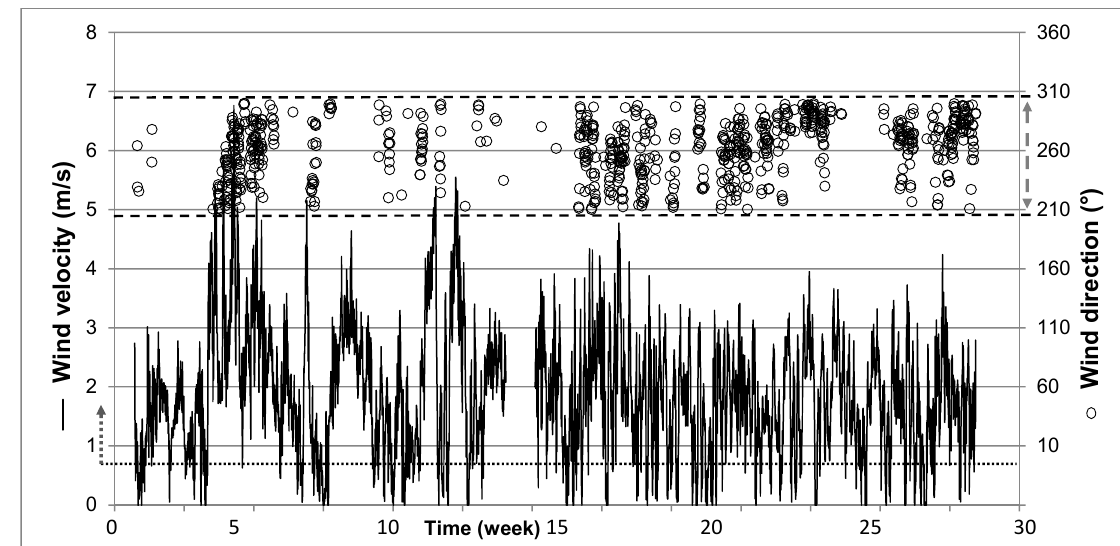
Figure 3. Time axis over 24 weeks (starting point x-axis 1 January 2013) with hourly mean values ( n = 4032) of wind velocity (≥0.7 m/s; solid line; n = 3395) in the lower part and wind direction (ο, open circle) between 210° and 300° ( n = 710) in the upper part of the Figure.